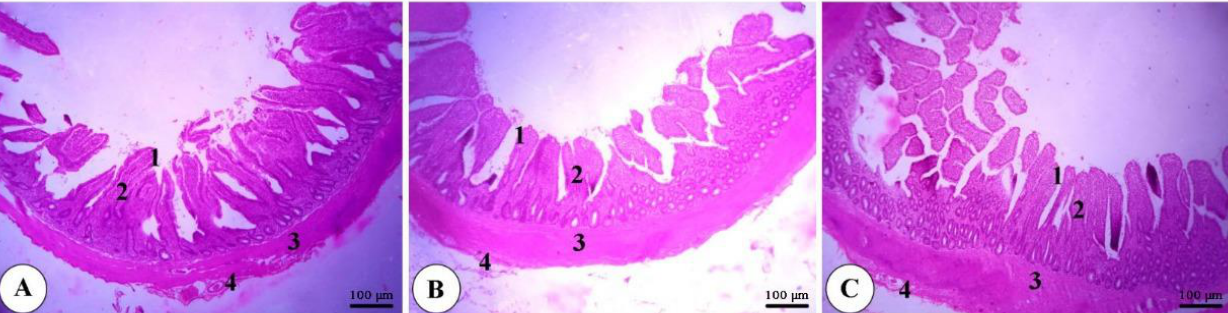
Figure 1. Representative photomicrograph of the duodenum of a broiler of the dry feed ( A ), wet feed ( B ) and fermented wet feed ( C ) groups showing the simple columnar epithelium of the tunica mucosa (1), connective tissue core of intestinal villi (2), intestinal glands (3), tunica muscularis (4) and tunica serosa (5). H&E, bar = 100 µm. ( n = 8).